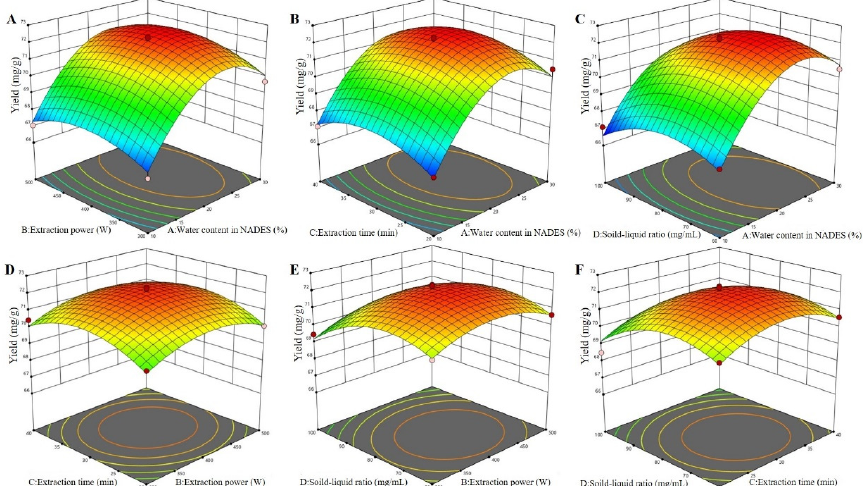
Figure 4. The 3D surfaces of the Box–Behnken design for NADES-MAE optimization. Water content in the NADES and extraction power ( A ); water content in the NADES and extraction time ( B ); water content in the NADES and solid–liquid ratio ( C ); extraction power and extraction time ( D ); extraction power and solid–liquid ratio ( E ); and extraction time and solid–liquid ratio ( F ). 3.5. Antimicrobial Activity of Total Flavonoids from Perilla Leaves The antimicrobial activities of perilla leaf extracts on bacteria and fungi have been investigated in many studies [3,5]. To evaluate the availability of total flavonoids from perilla leaves by using NADES groups, antimicrobial activities against E. coli , S. aureus , B. subtilis , and C. albicans were carried out in this study, respectively. The results of the inhi- bition zone diameter are summarized in Table 4. As expected, the positive control had the strongest inhibition effect on all microbial strains and no obvious inhibition zone was ob- served on the medium with only the DMSO solution. The total flavonoid compounds showed weakest inhibition effects toward E. coli (7.48 ± 0.80 mm), compared with S. aureus (15.47 ± 0.35 mm), B. subtilis (14.92 ± 0.62 mm), and C. albicans (11.33 ± 0.31 mm). According to the above results, S. aureus and B. subtilis were the two strains most susceptible to perilla